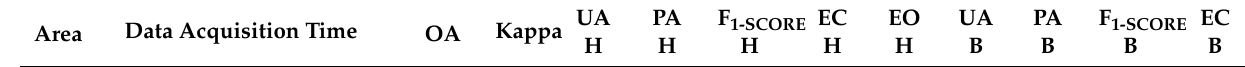
Figure 12. An example of Spearman’s correlation matrices for data acquired in spring (on the left) and autumn (on the right) in the UB area.